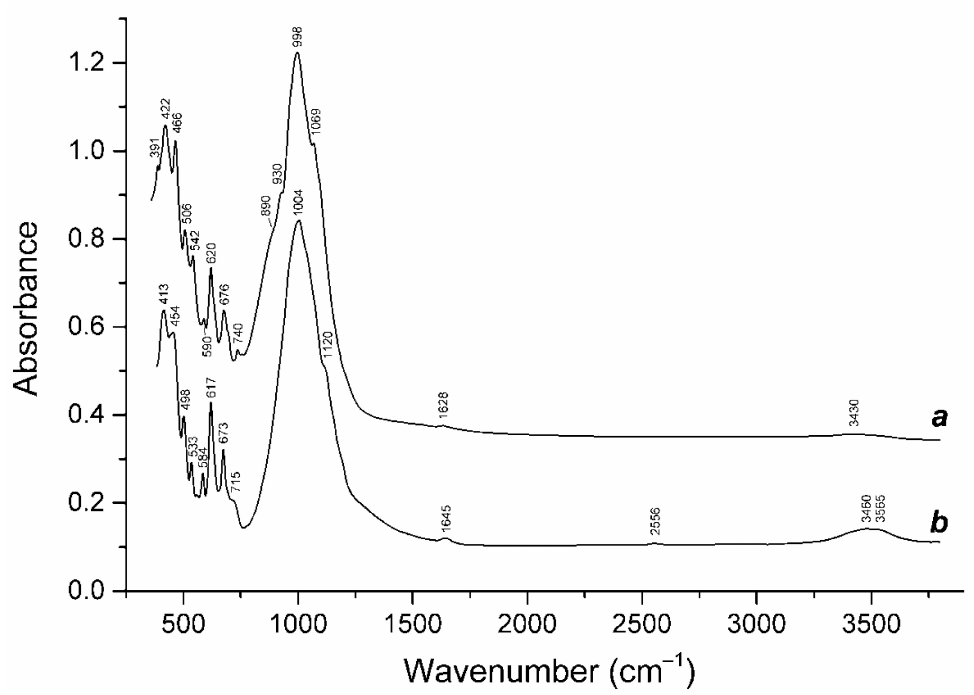
Figure 9. Infrared spectra of ( a ) bystrite (Sample 9) and ( b ) sulfhydrylbystrite (Sample